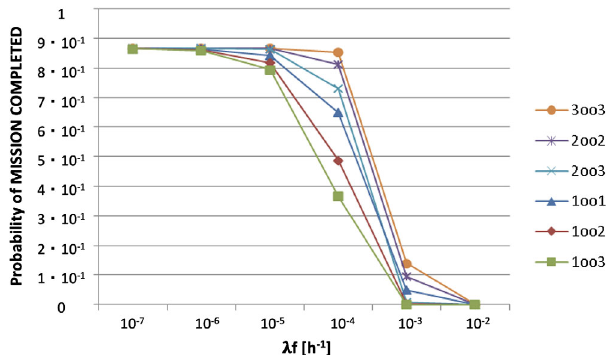
FIG. 12. Case I: Probability of mission completed against λ f between 1 × 10 − 7 h − 1 and 1 × 10 − 2 h − 1 .